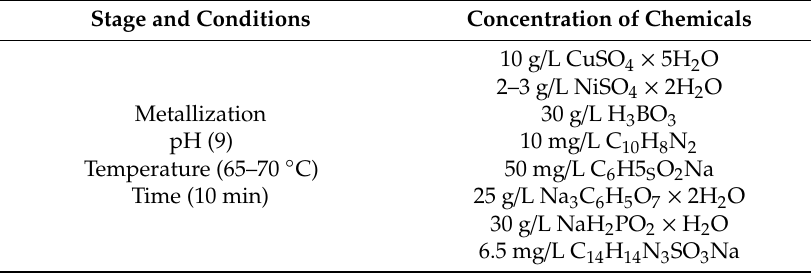
Table 5. The Solution Composition and Experimental Conditions of Electroless Copper–Nickel Double